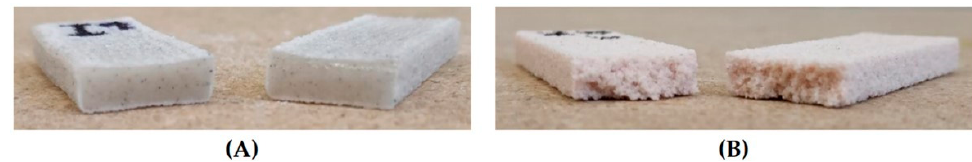
Figure 11. Example of fractured specimens. ( A ) Horizontally built specimen, with 0% sand, display- ing a smooth fracture surface. ( B ) A similar specimen built with 60% sand, displaying a granular and irregular type of fracture surface.